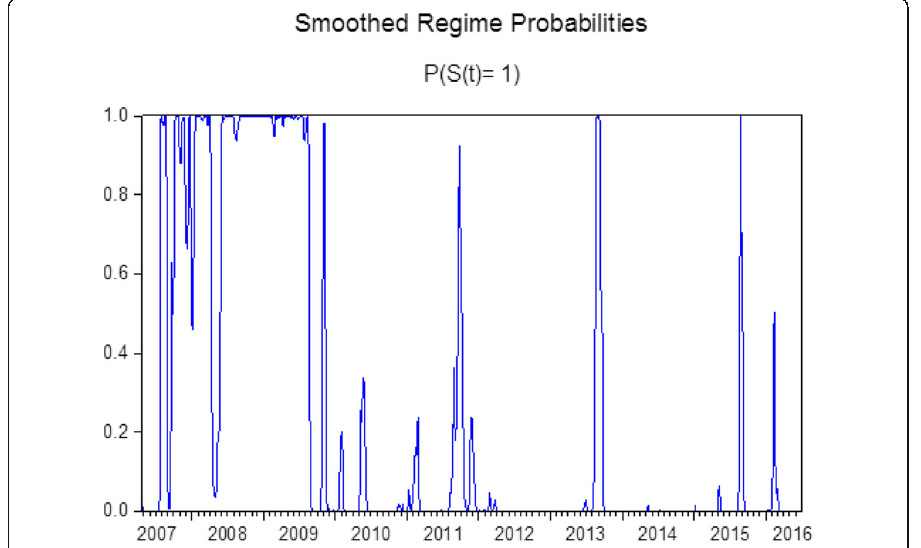
Fig. 5 Smoothed Regime Probabilities of Indian Reachable Stock Index